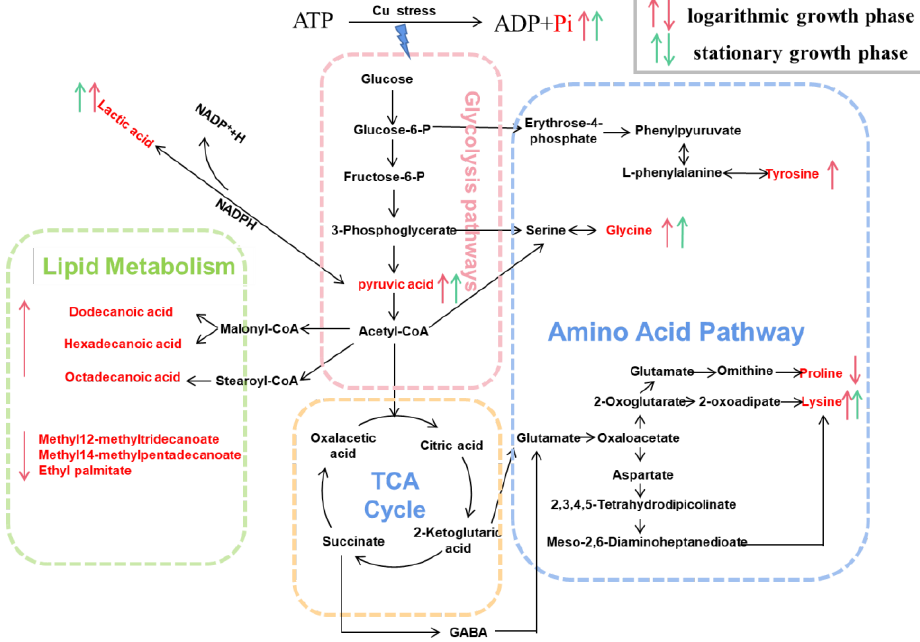
Figure 5. Metabonomics reveals Planococcus sp. O5 copper tolerance mechanisms. The identified significantly different metabolites were integrated into pathways. The down and up arrow means down-regulation and up-regulation, respectively.